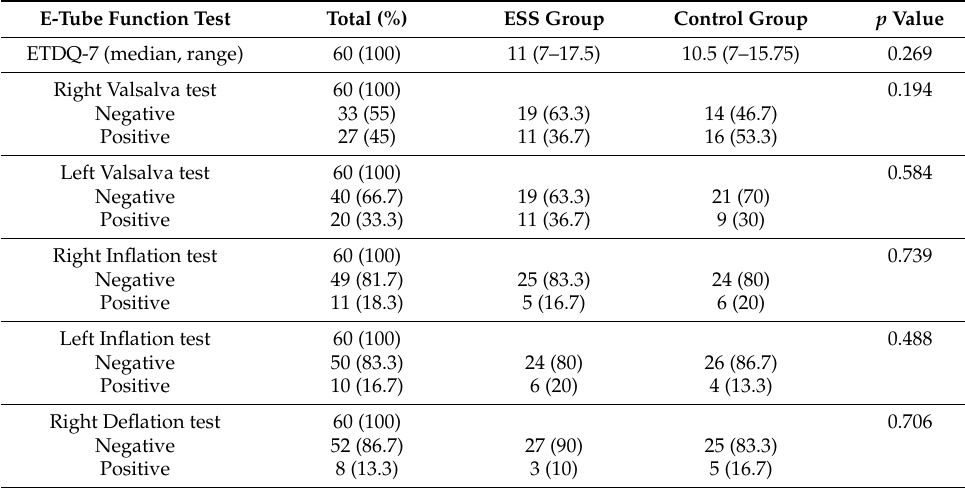
Table 2. Baseline eustachian tube function test results of the